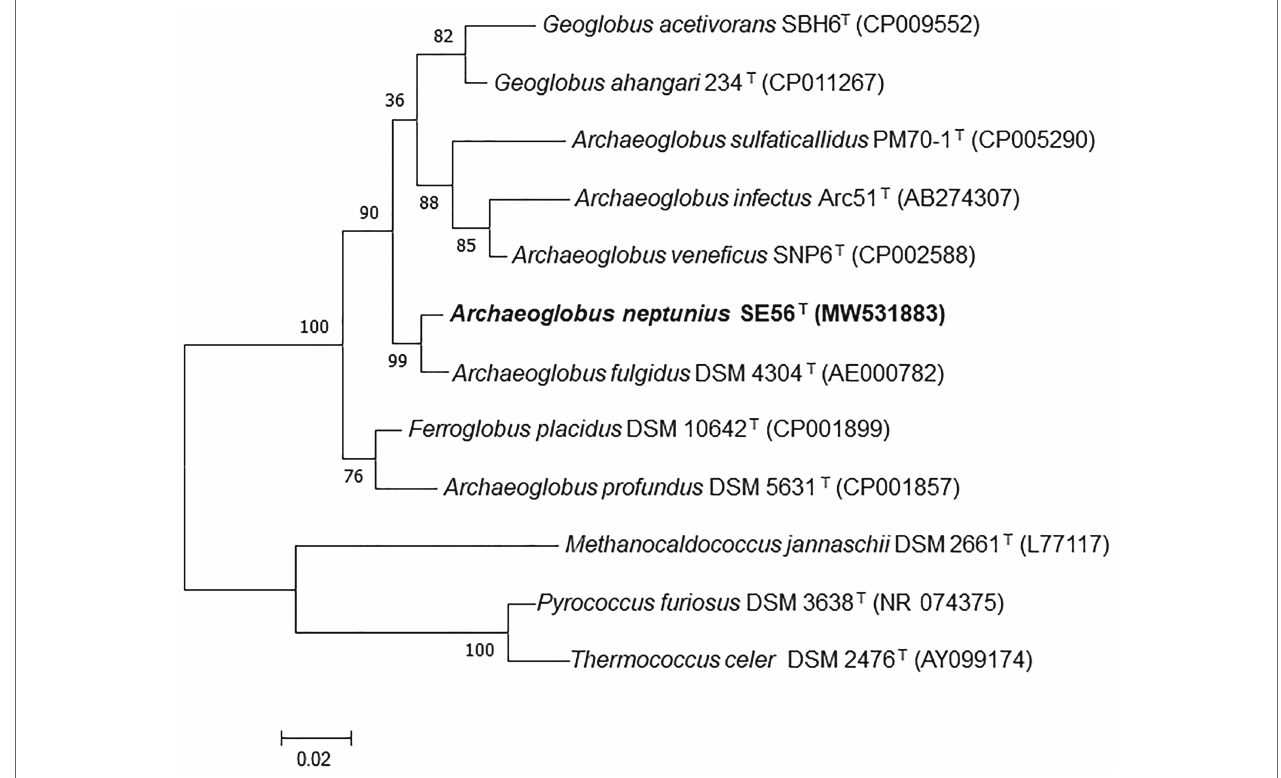
FIGURE 1 | Maximum-likelihood phylogenetic tree based on 16S rRNA gene sequences showing the position of the strain SE56 T among the other members of the class Archaeoglobi . Bootstrap values based on 1,000 replicates are shown at branch nodes. Methanocaldococcus jannaschii DSM 2661 T , Pyrococcus furiosus DSM 3638 T , and Thermococcus celer DSM 2476 T were used as outgroup. Bar, 0.02 substitutions per nucleotide position.